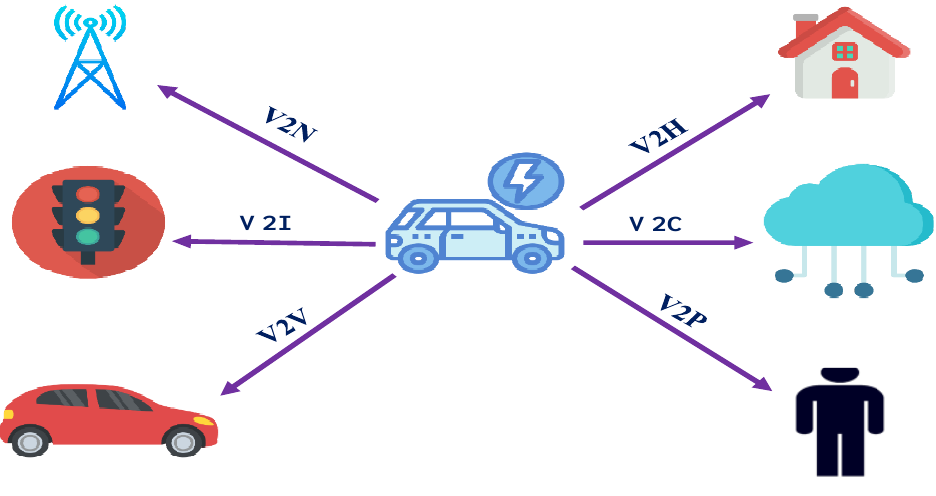
Figure 11. Vehicle-to-everything (V2E) protocol illustration.